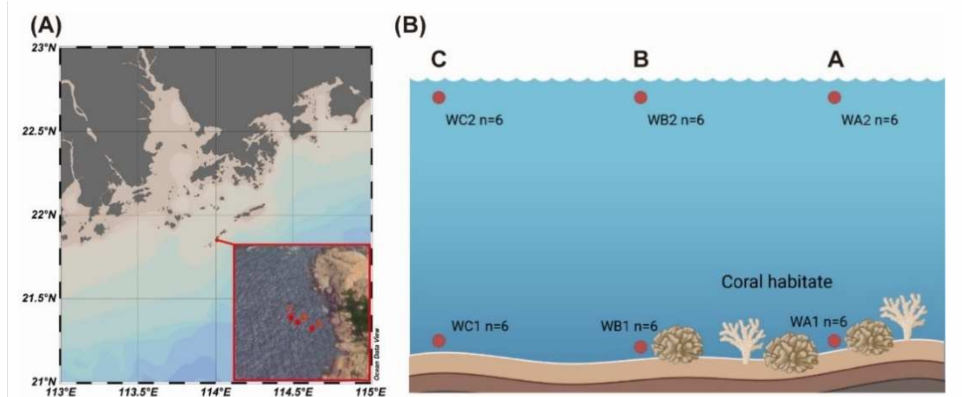
Figure 1. Map of the sampling stations. ( A ) Location of Miaowan Island in South China Sea and location of sampling stations. ( B ) Sampling sites of each station are in the surface and bottom of the water column. Station A is in the center of coral habitat. Station B is the marginal area of coral habitat. Station C is the non-coral